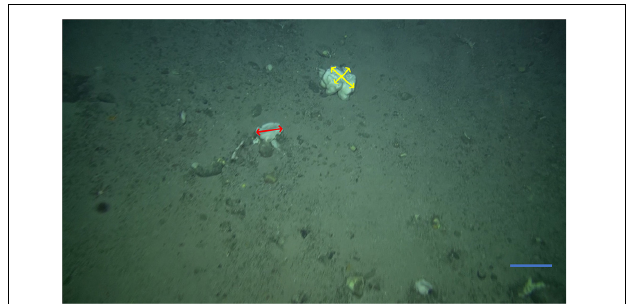
FIGURE 3 | Measurements carried out on the width of a flabellate (“fan-shaped” sponges, pointed with the red arrows) and “length” and “width” in a massive sponge (pointed with the yellow arrows). Scale bar: 30 cm.